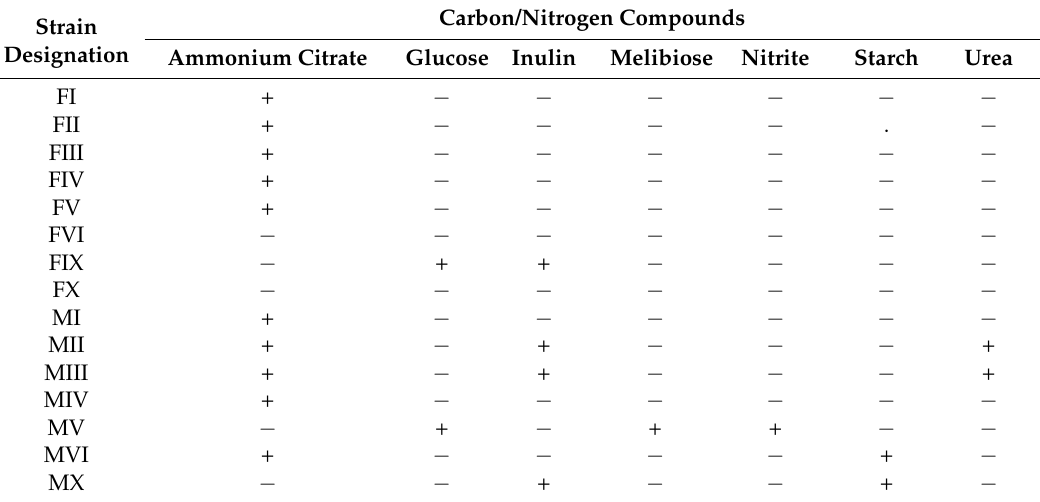
Table 3. Assimilation of different carbon/nitrogen compounds by selected S. cerevisiae flor yeasts, analyzed with microtiter technology. Values are expressed as (+) if yeast strains were able to assimilate the carbon/nitrogen source and ( − ) if yeast strains were not able to assimilate them.